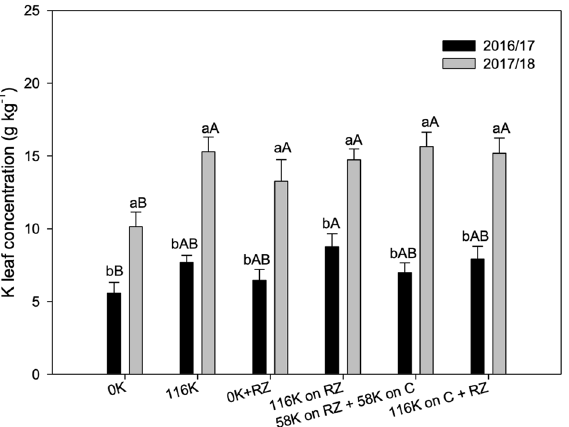
Figure 2. Potassium leaf content in cotton leaves under potassium fertilization management. A > B for K management within each growing season and a > b for growing season within K management.